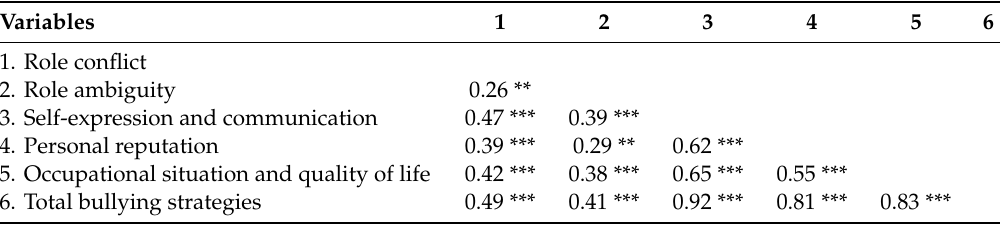
Table 1. Relationships between the